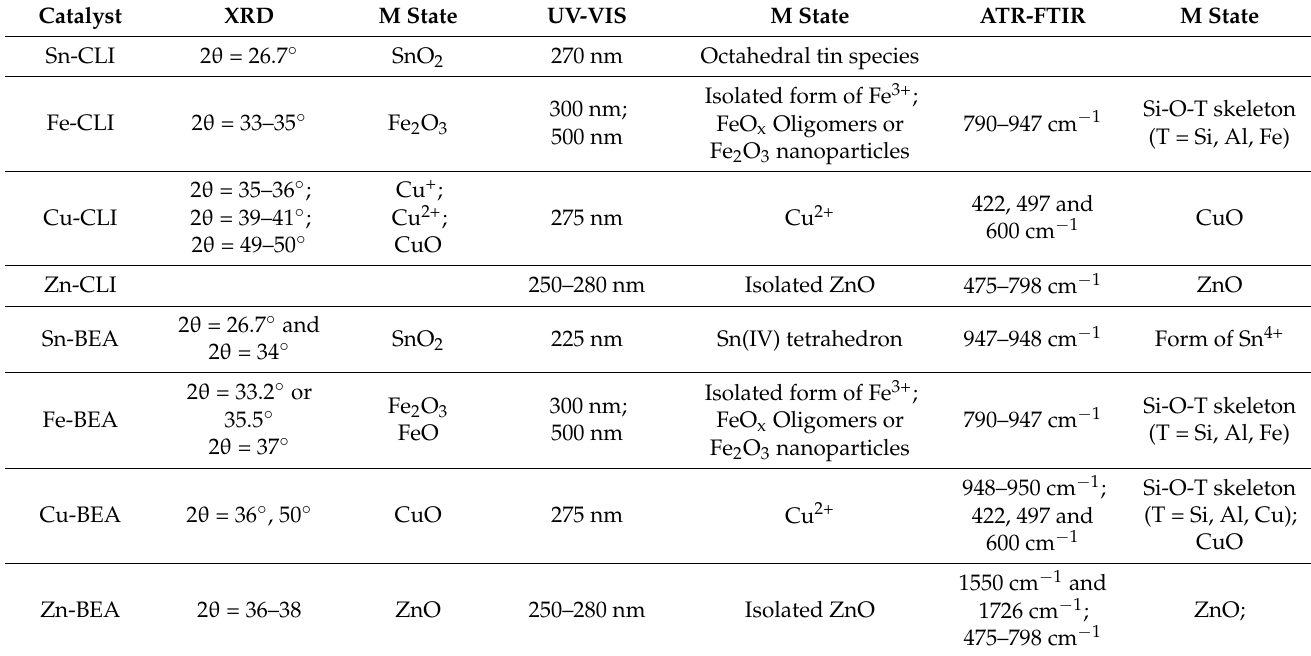
Table 2. Properties of the samples and the metal states deduced.